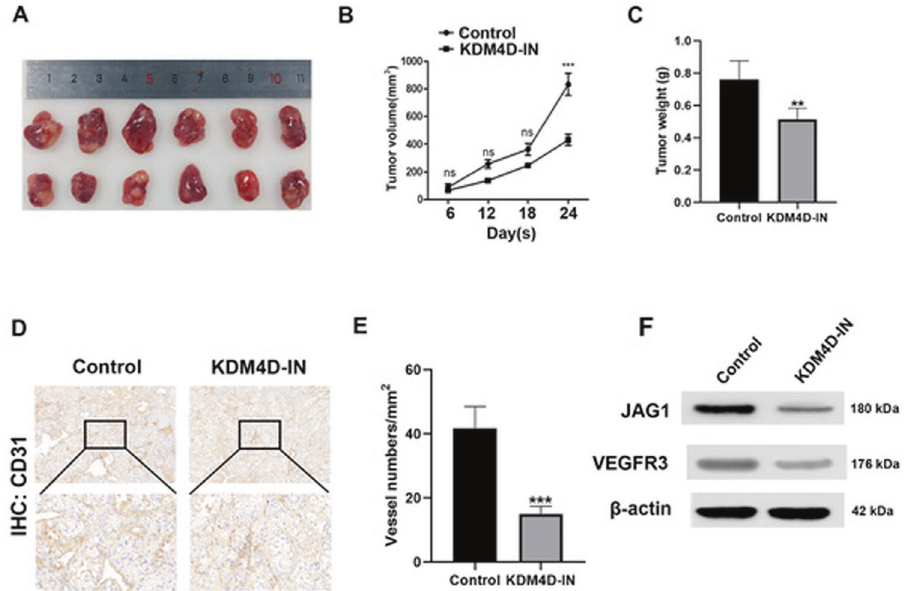
Fig. 6 KDM4D inhibition suppresses tumor growth and angiogenesis in animal model. A Images of transplanted tumors excised from nude mice. B Tumor growth was signi fi cantly inhibited in KDM4D-IN group. C KDM4D inhibition tumors show a signi fi cant decrease in tumor weight. ** p < 0.01 and *** p < 0.001. D Immunohistochemical staining was used to detect the expression of CD31 in two groups of transplanted tumors. E Quantitive analysis of vessel numbers based on the IHC staining of CD31. *** p < 0.001. F Images of Western blot